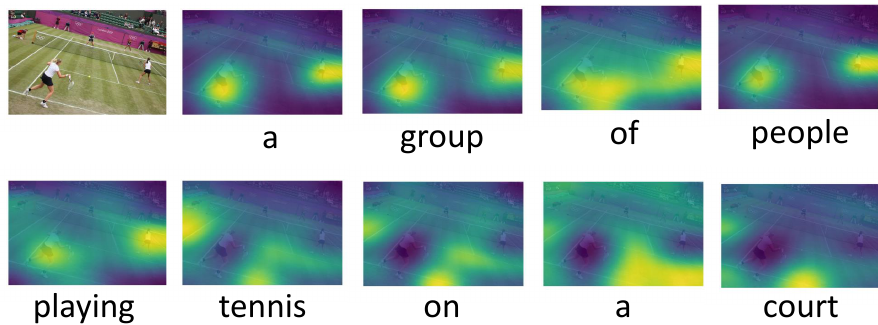
Figure 6. Some generate captions of our model from images taken by ourselves.